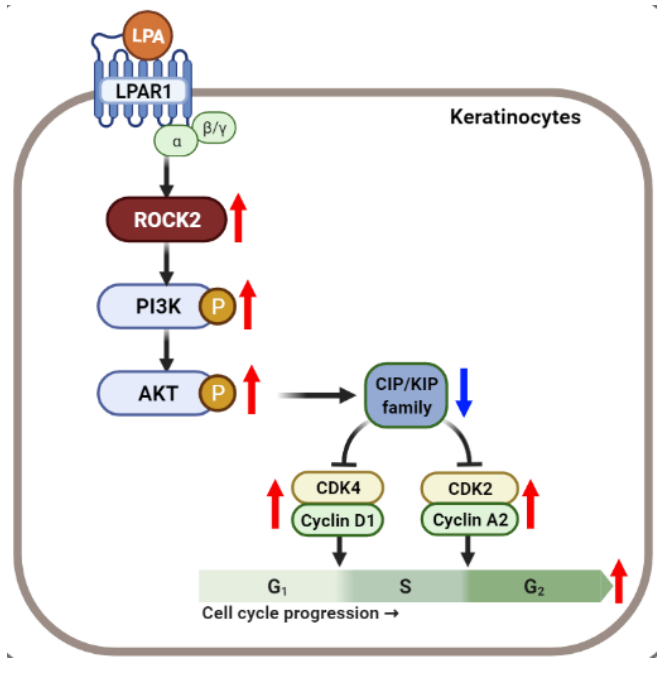
Figure 8. Schematic representation of the mechanism of LPA-mediated cell cycle progression via ROCK2/PI3K/AKT signaling in keratinocytes. Created with BioRender.com. Red and blue arrows indicate upregulated and downregulated responses, respectively.